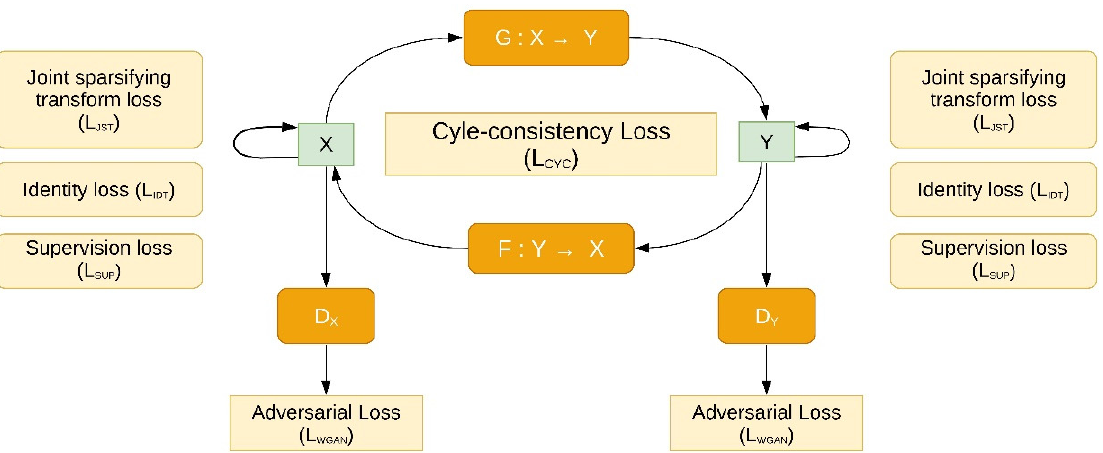
Figure 3. Basic GAN-CIRCLE network. Here, X is a set of LR CT scans and Y is the corresponding HR CT scans. The network has two GAN modules, a low-to-high image reconstructor (Generator G, Discriminator DY) and a high-to-low image reconstructor (Generator F, Discriminator DX). Different loss functions are harmoniously coupled for training the network and monitored with regularized cycle-consistency and identity loss to prevent overfitting. Figure is adapted from [63]. Table 3. Summary table of data augmentation methods using